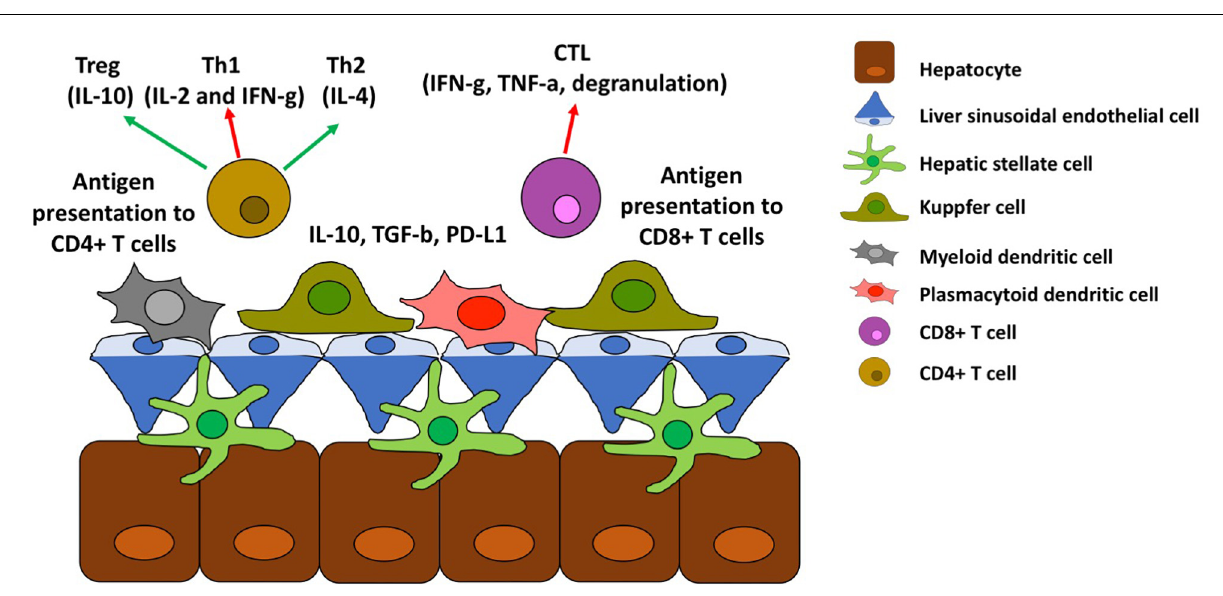
FIGURE 3 | Antigen presentation in the liver. Schematic representation of antigen presentation to CD4+ and CD8+ T cells and its effect toward tolerance (red arrows) or immune activation (green